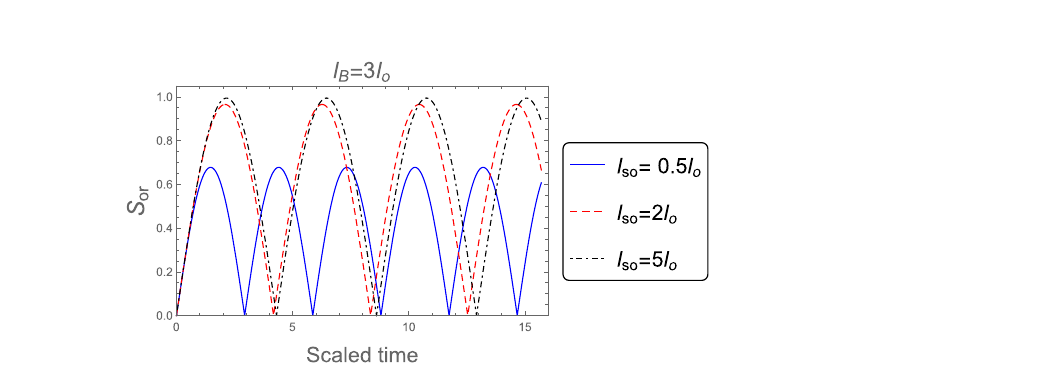
Figure 4. The orthogonality, S or , when the system’s initial state in the maximum entangled state 1 �( 0 ) ( ) , for distinct values of SOC strength l so e, 0 g, 1 √ 2 | � = | � + | � 0.5 l o is employed. magnetic field l B =